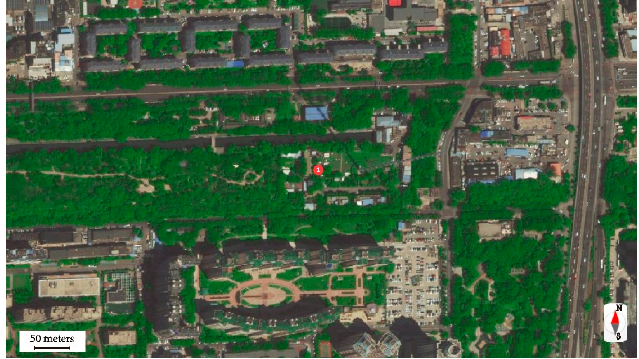
Figure 1. Location of the experimental site in this study.